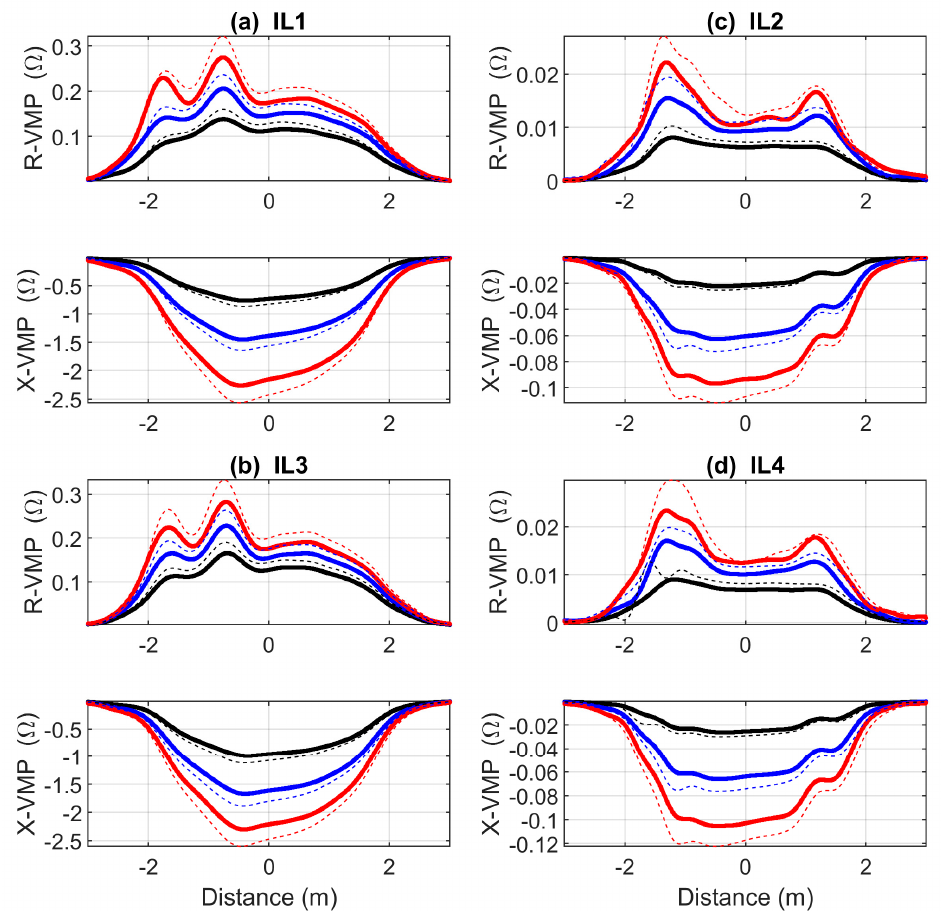
Figure 3. Exemplary VMPs of a Hyundai ix35 presented as a function of the distance traveled; thick lines apply to an unloaded car; thin dashed lines refer to a vehicle loaded with a mass of 306 kg; red VMPs are obtained at a high frequency component; blue VMPs are obtained at an intermediate value of the frequency component; black at the lowest frequency component, according to the operating frequencies listed in Table 1.